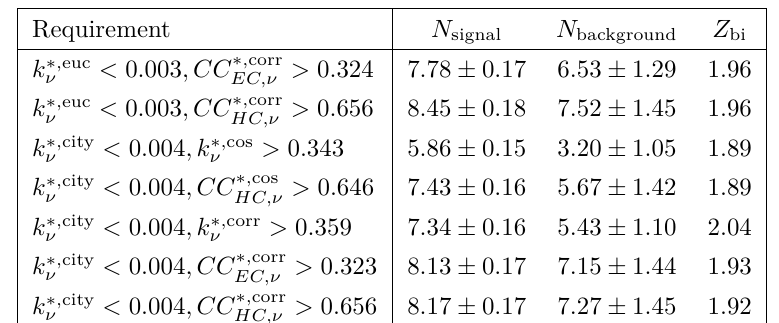
Figure 4. Event rates as a function of useful network metrics for our prototype electroweakino analysis calculated using d city . Events in the overflow bin are not shown in the distribution but are included in the Z bi calculation.